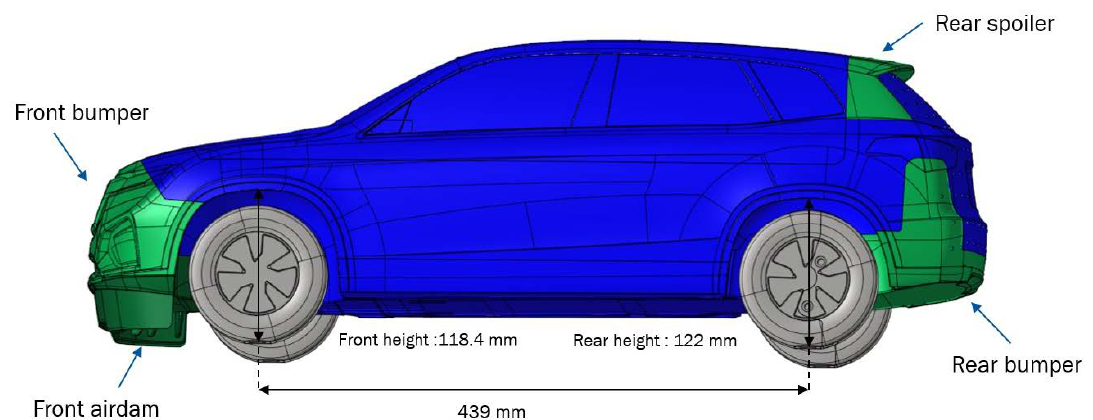
Figure 1. Modules in green can be removed from the blue mockup in order to test different variants of the front and rear bumper, front air dam and rear spoiler.